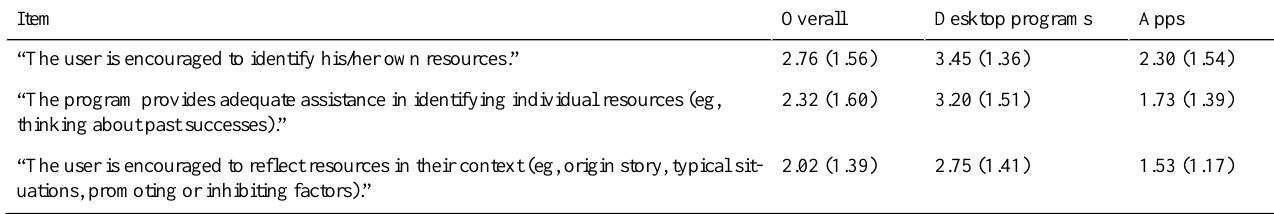
Table 9. Mean (SD) scores in the evaluation of resource activation features of web-based interventions.